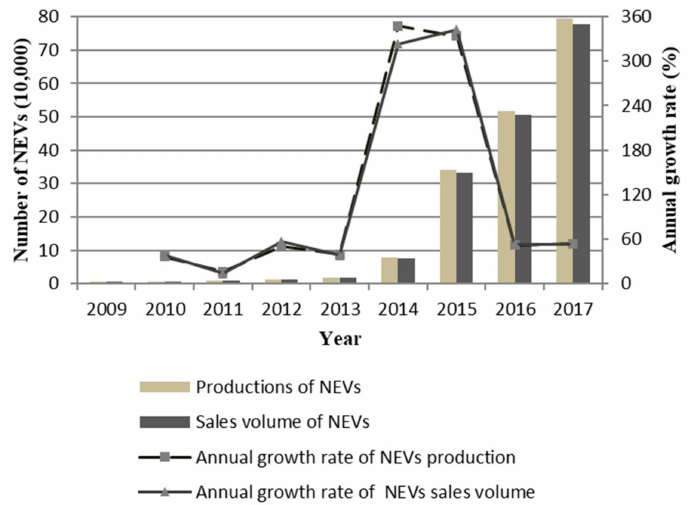
Figure 2. Productions, sales volume, and annual growth rate of NEVs between 2009 and 2017 in